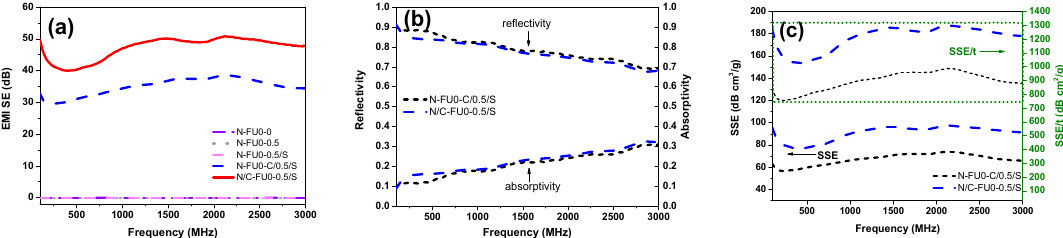
Figure 7. ( a ) EMI SE curves of MFRCs, ( b ) reflectivity and absorptivity of MFRCs, and ( c ) specific SE (SEE) and absolute EMI SE values (SSE/t) of MFRCs.